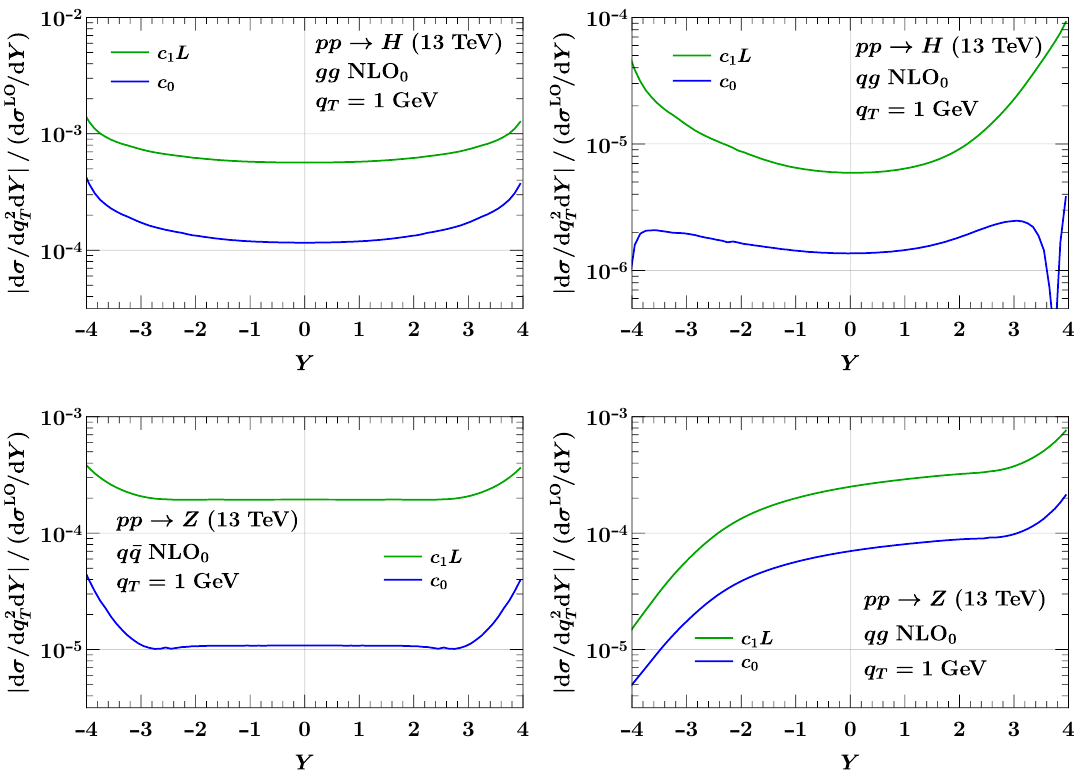
Figure 3 . Rapidity dependence of the LL (green) and NLL (blue) power corrections for Higgs and Drell-Yan production at NLO, relative to the LO rapidity dependence. The q (cid:22) q channel for Higgs production is not shown, as its LL power corrections